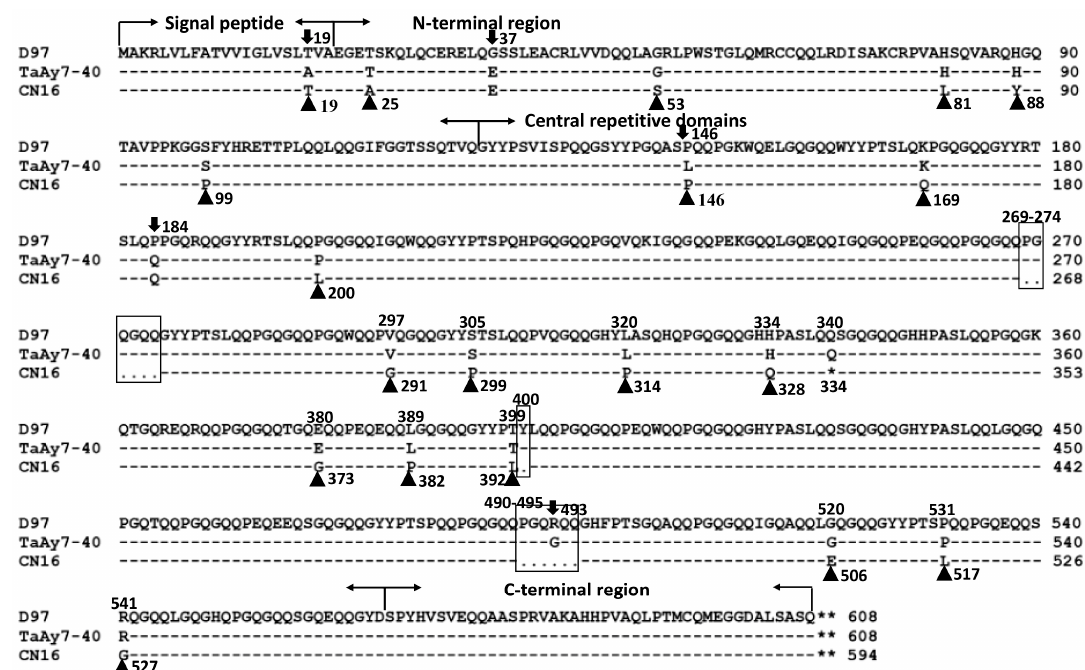
Figure 5. Identification of single amino acid polymorphisms (SAPs) and InDels of the 1Ay amino acid sequences in D97 (KC545956), TaAy7-40 (KC545952), and CN16 (KC545955). Triangles depict the different SAPs between CN16 and TaAy7-40; the down arrows indicate the different SAPs between D97 and TaAy7-40; the boxes represent the InDels. The single star depicts the premature termination codon in CN16 but not in TaAy7-40 and D97.